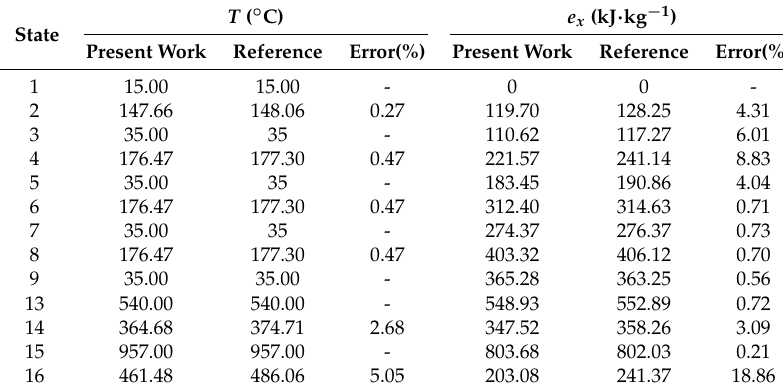
Table 4. Comparison between obtained results and data published in [41] for compression and expansion